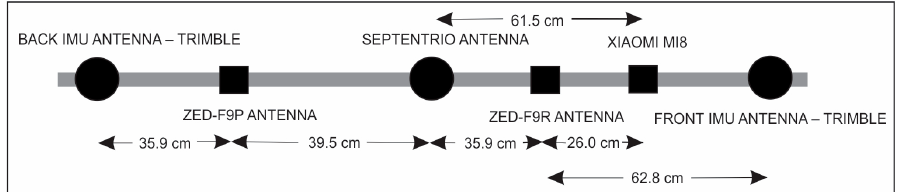
Figure 3. The setup of the Trimble antennas of the MMS (at the front and rear of the vehicle), Septentrio PolaNt-x MF multi-frequency GNSS antenna, Xiaomi Mi8 smartphone and low-cost antennas ANN-MB-00 from ZED-F9P and ZED-F9R with the horizontal distances.